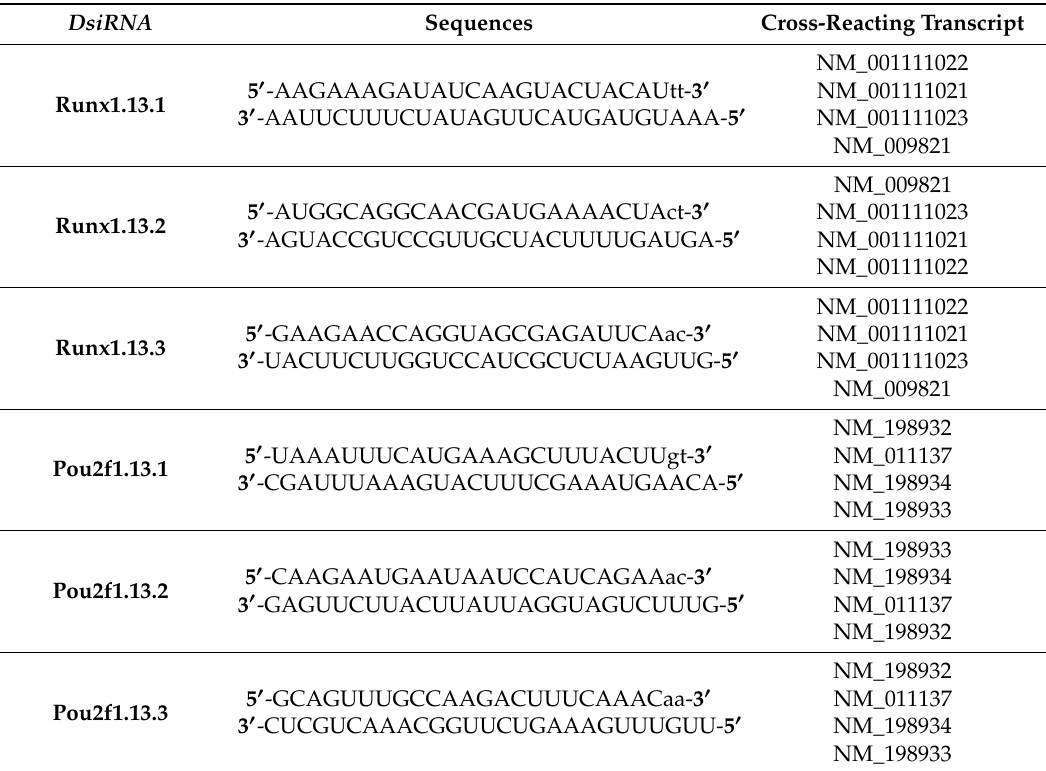
Upper case letter represent RNA bases, while lower case letters correspond to DNA